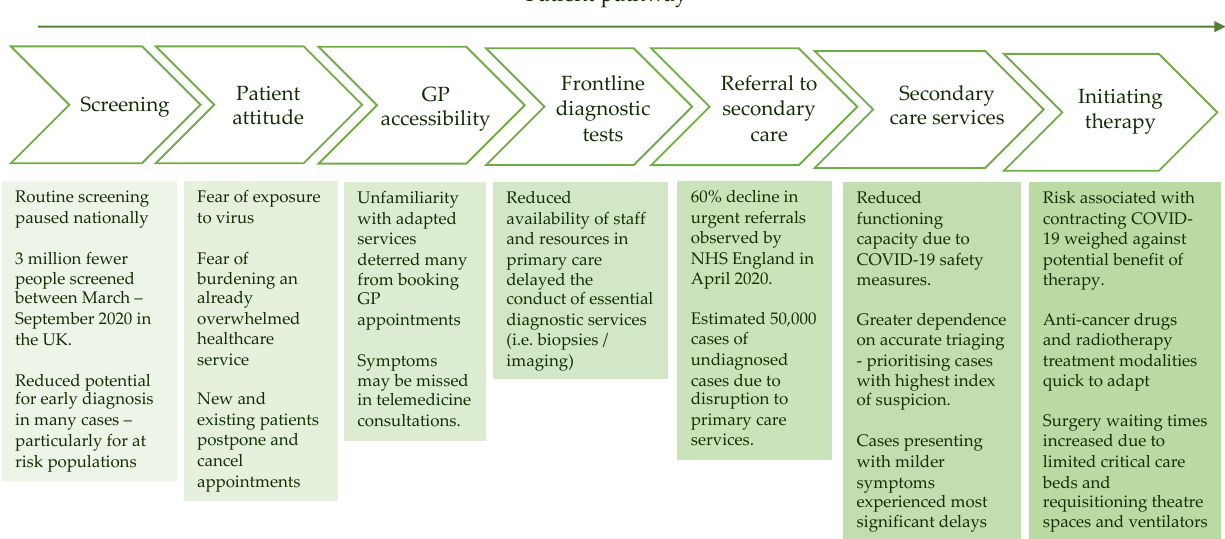
Figure 1. Impact of COVID-19 on the oncology care